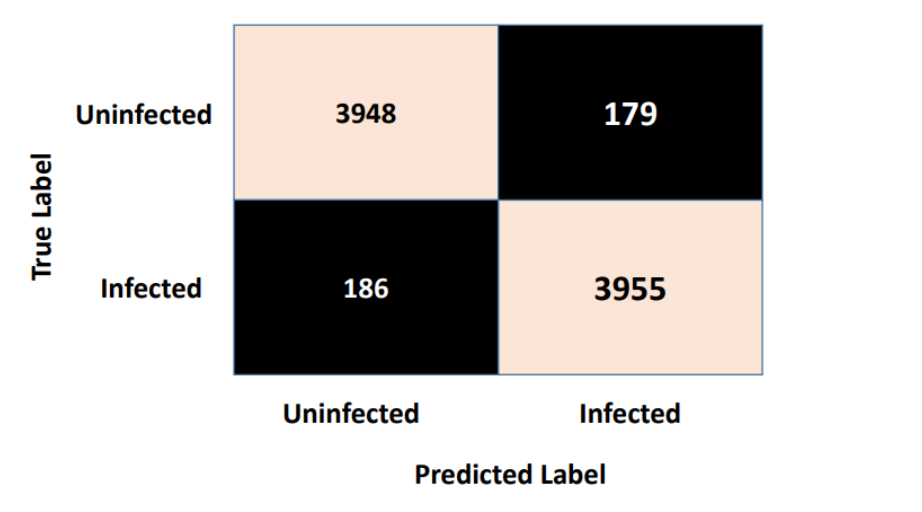
Figure 7. Confusion matrix of the malaria